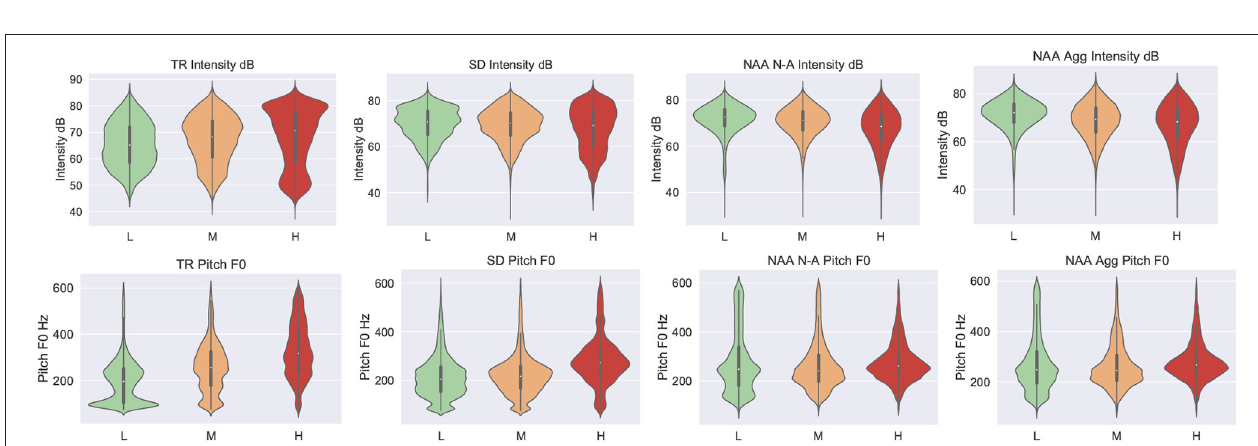
FIGURE 3 | Violin plot representation for the pitch (F0) and intensity (dB) vocal behavior for each of the corpora in utilized in this study. Summarized across all speakers. cf. Figure 2 for legend.